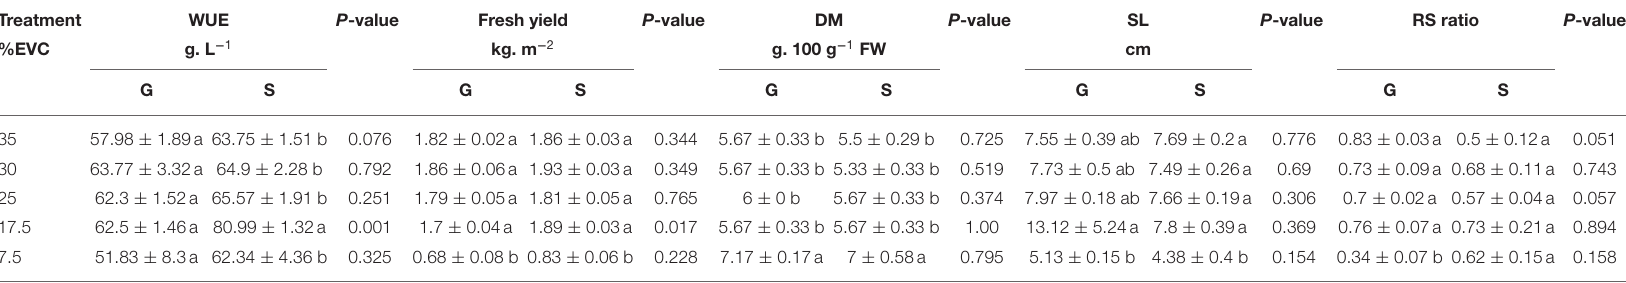
Different letters in the same column indicate significant difference at P < 0.05 (Fisher LSD test with 95% confidence). P-values for the effect of irrigation method at each irrigation level are presented in a separate column next to each parameter.